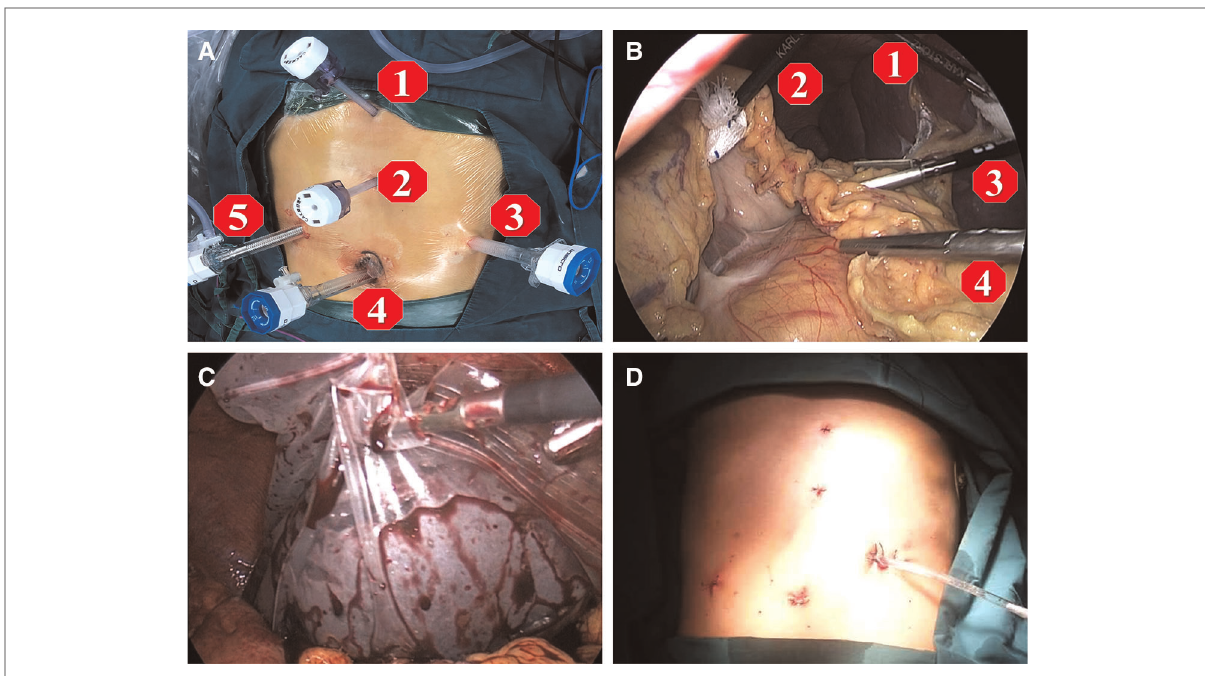
FIGURE 2 Five ports technique is applied for the operation as shown in fi gures. ( A,B ) port 1 and 2 are assigned for the fi rst assistant, port 3 and 4 are main operation ports for the operator, and port 5 is the observation port for the second assistant. In order to obtain the best view for operation, the second assistant need to adjust the 30° angle of laparoscope to fi t the view of operator; ( C ) at the end of operation, the spleen was placed into a plastic specimen bag, then smashed and removed from the abdominal cavity by enlarging the incision of the 12 mm port 3; ( D ) after surgery, a drainage tube was placed at Spleen Fossa for postoperative